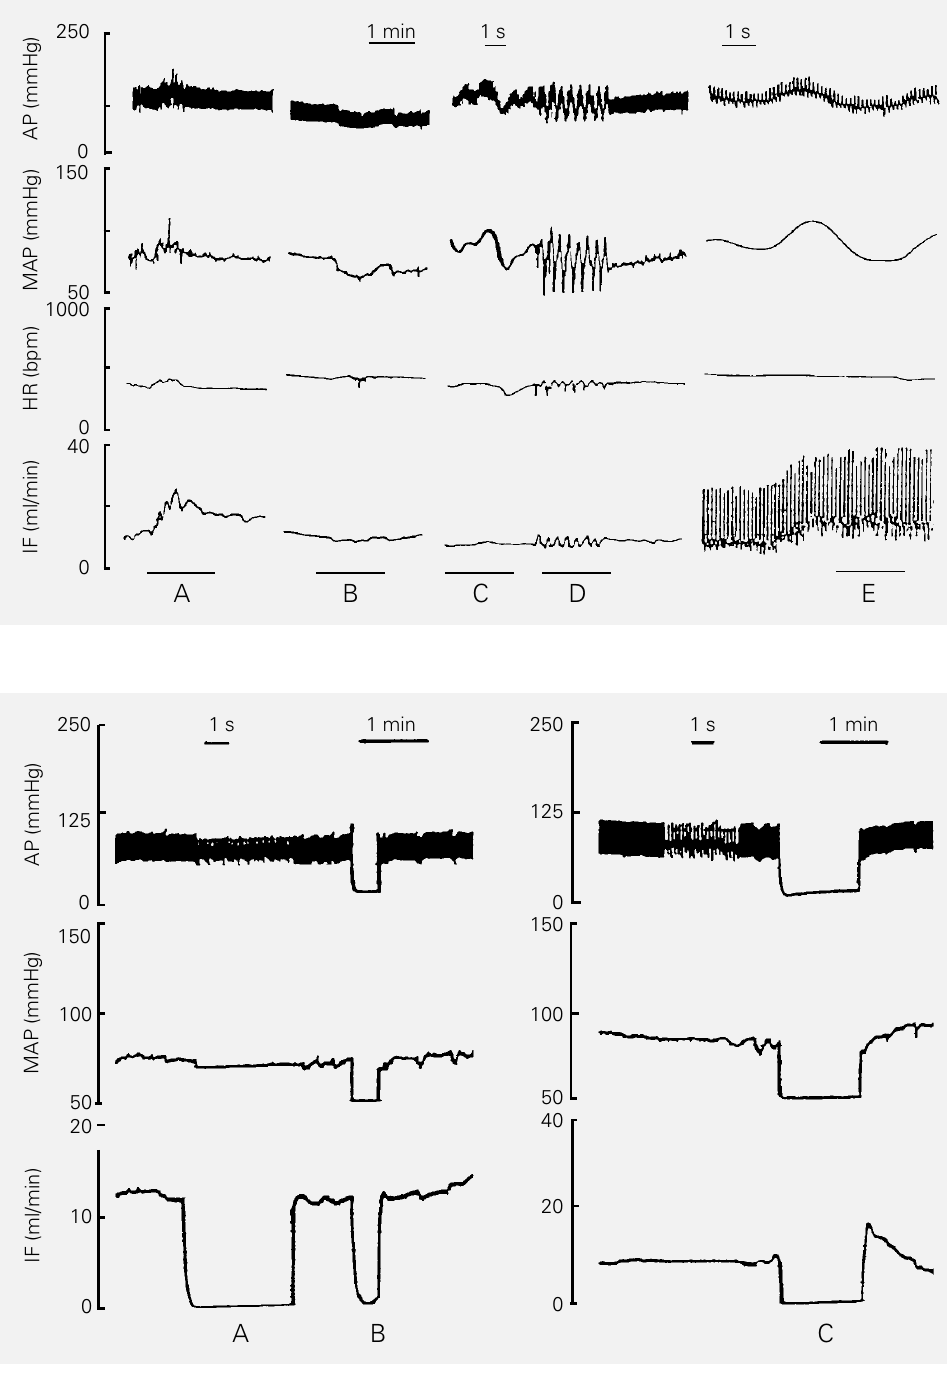
Figure 3 - Records of pulsatile (AP) and mean arterial pressure (MAP), heart rate (HR) and mean or pulsatile iliac flow (IF) in freely moving rats with a 1-mm probe chronically implanted around the iliac artery. See text for explana- tion.